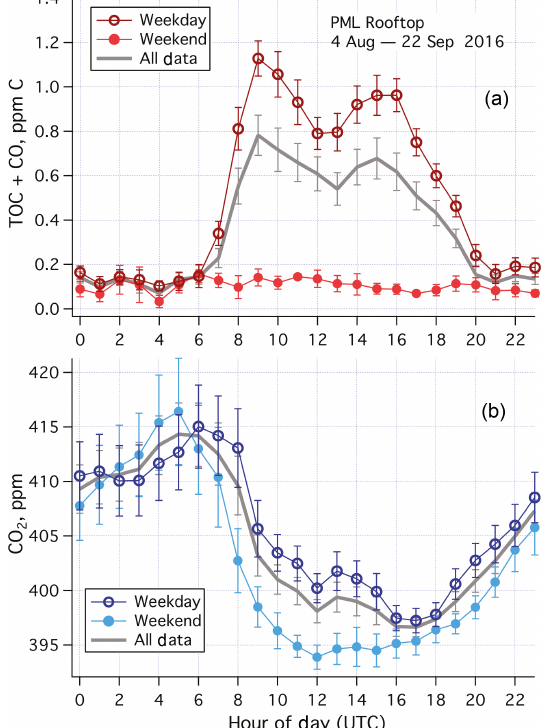
Figure 4. (a) Averaged diurnal cycle in TOC + CO and (b) CO 2 for weekdays, weekends–holidays, and all data during the 1.5-month measurement campaign from the rooftop of Plymouth Marine Lab- oratory. Error bars indicate standard errors. TOC + CO was much higher during weekdays than weekends, especially in the daytime. Limited diel variability in TOC + CO was observed in the week- end data. CO 2 was also higher in the daytime during weekdays than weekends. UTC here is 1h behind local time.